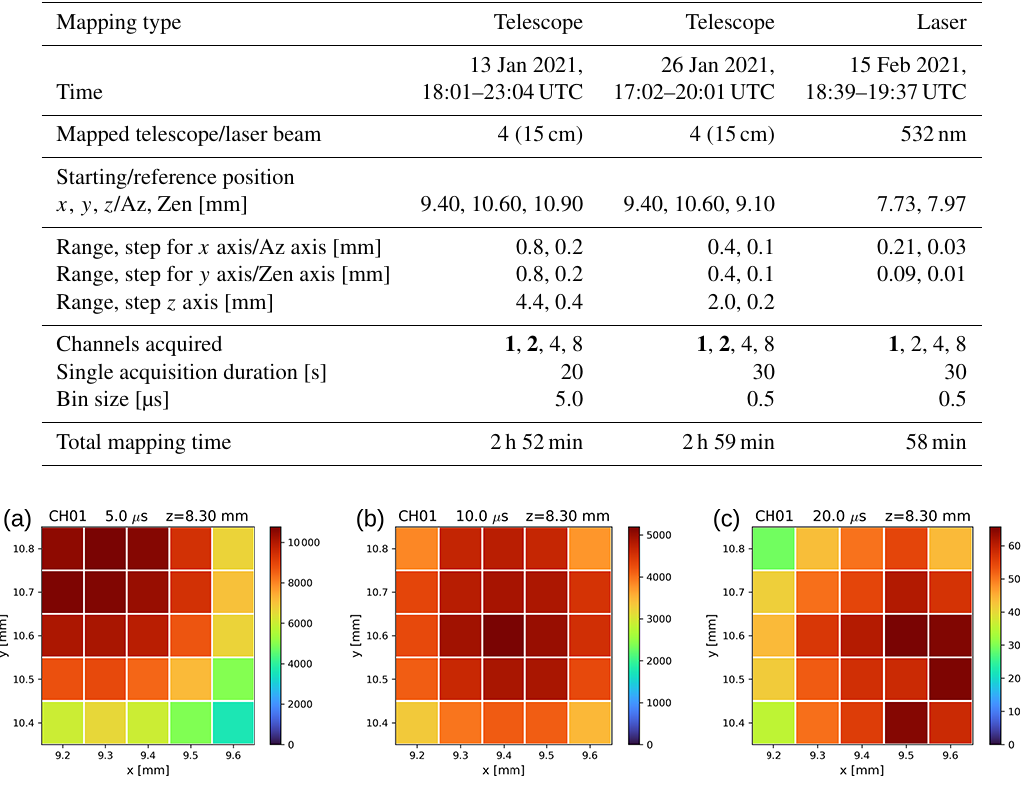
Figure 12. Signal mapping (CH01 photon-counting signal) of the second session (26 January 2021) at same z and different ranges ( a : 5.0µs – 750m; b : 10.0µs – 1500m; c : 20.0µs – 3000m). Here the signal is not normalized due to the lack of sufficient SNR from the second channel in the lower range (highly incomplete